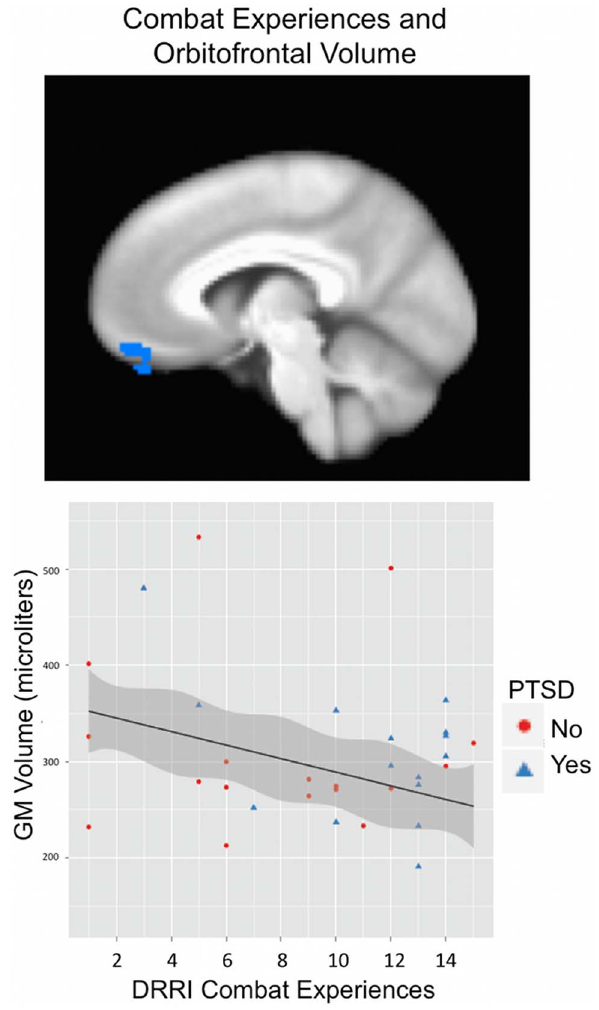
Figure 3. Greater combat experiences are associated with reduced gray matter volume in the orbitofrontal gyrus. Deployment experiences were measured using the Deployment Risk and Resilience Inventory (DRRI). Scores on the subscale corresponding to level of combat experiences related negatively to gray matter volume within the orbital frontal gyrus (BA 11; shown at x=6; see Table